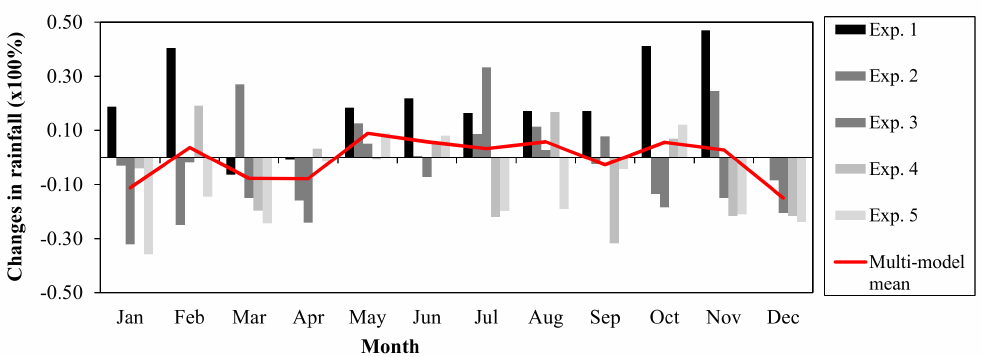
Figure 8. Changes in average monthly rainfall for the upper Thu Bon River basin in the near-term (2026–2035) climate projected by individual model experiments, relative to the baseline (1979–2008)